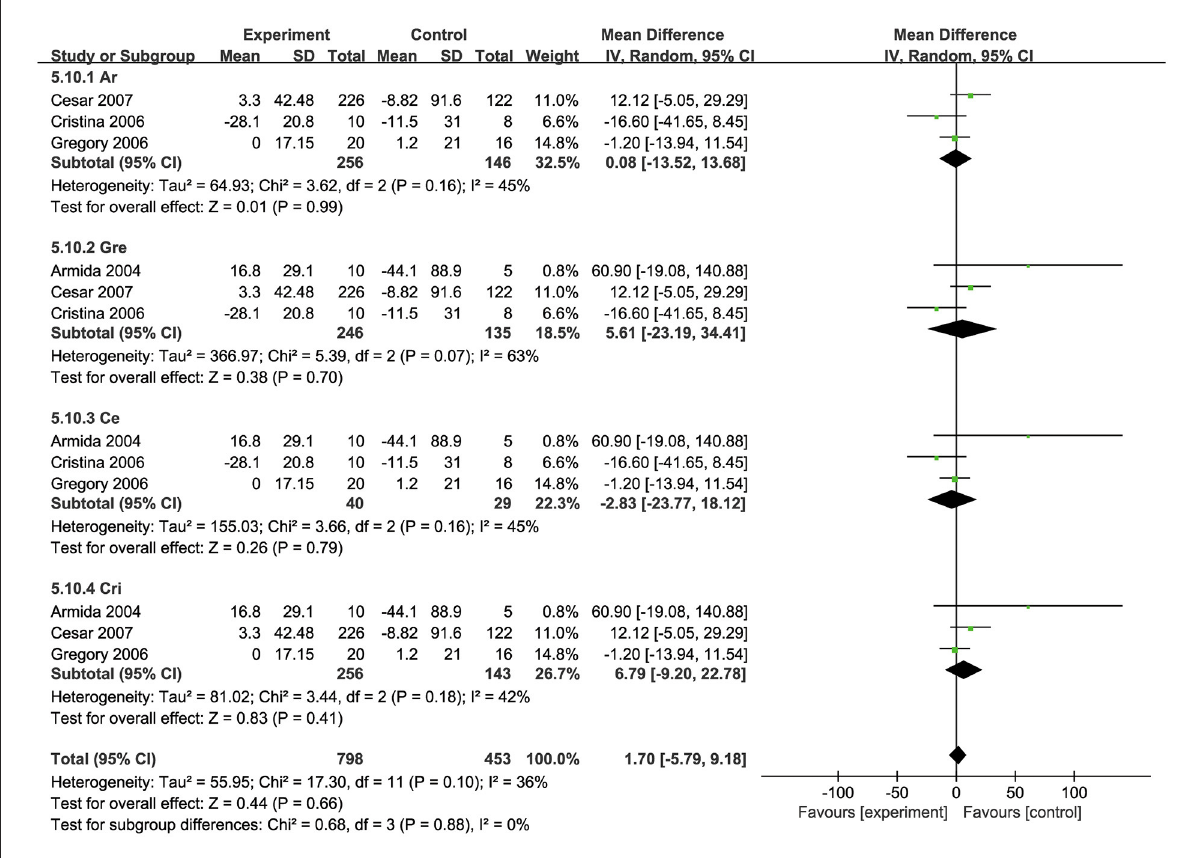
FIGURE7 Sensitivity analysis for the effects of biotin supplementation on insulin